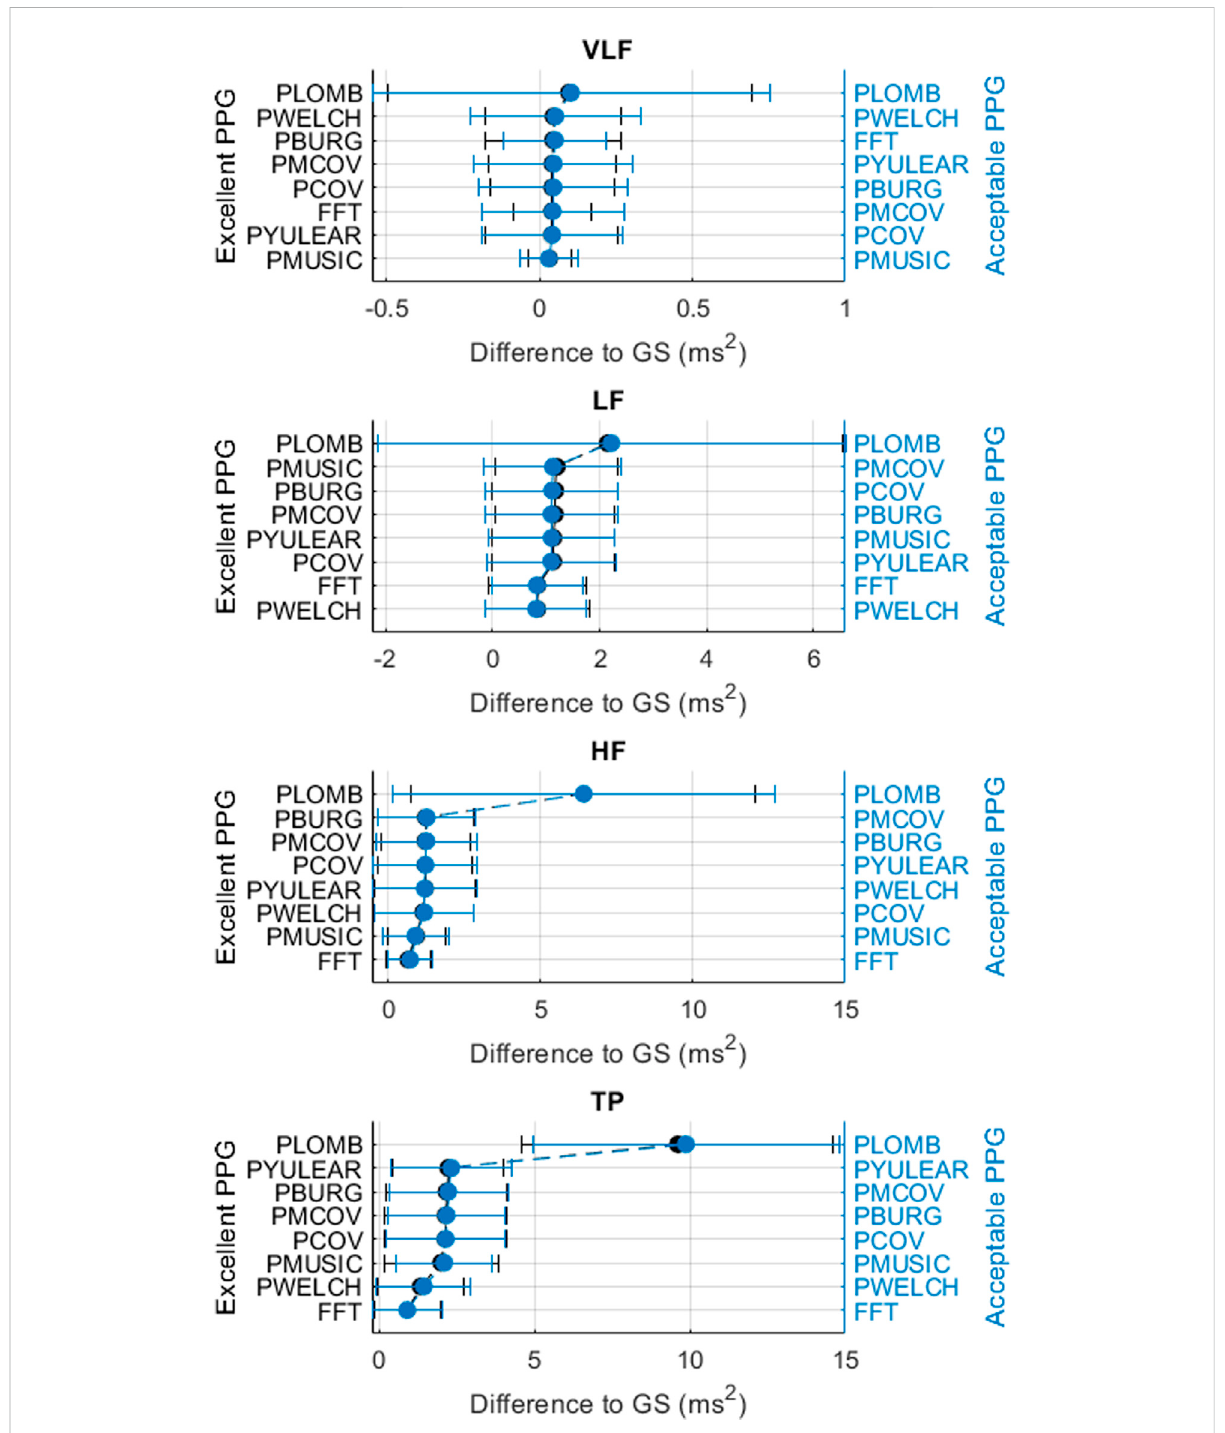
FIGURE 3 Mean and standard deviations of the differences obtained by comparing pulse rate variability absolute power frequency-domain indices obtained from extracted and gold-standard